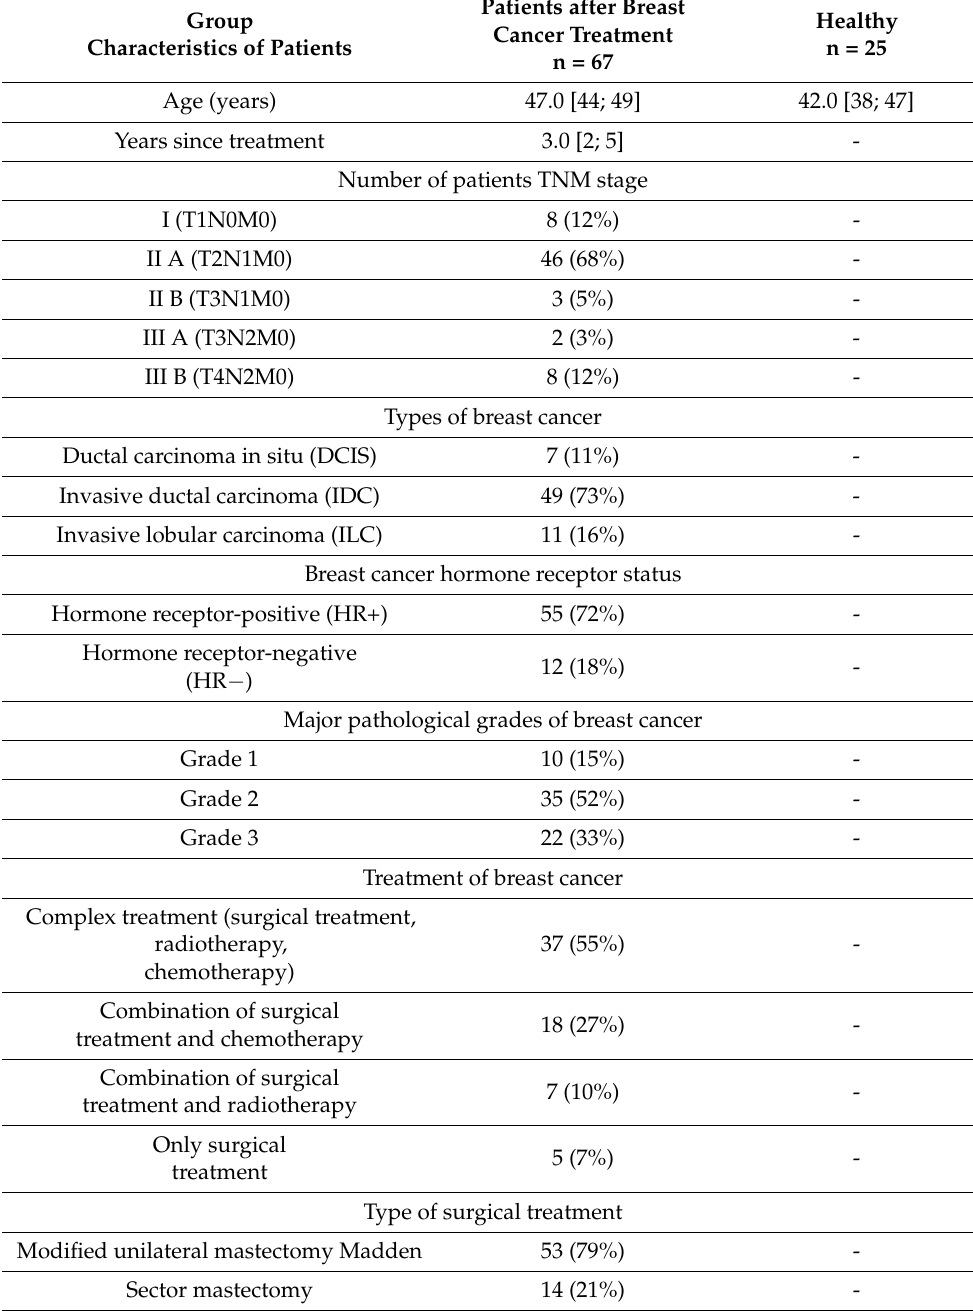
Table 1. Characteristics of the